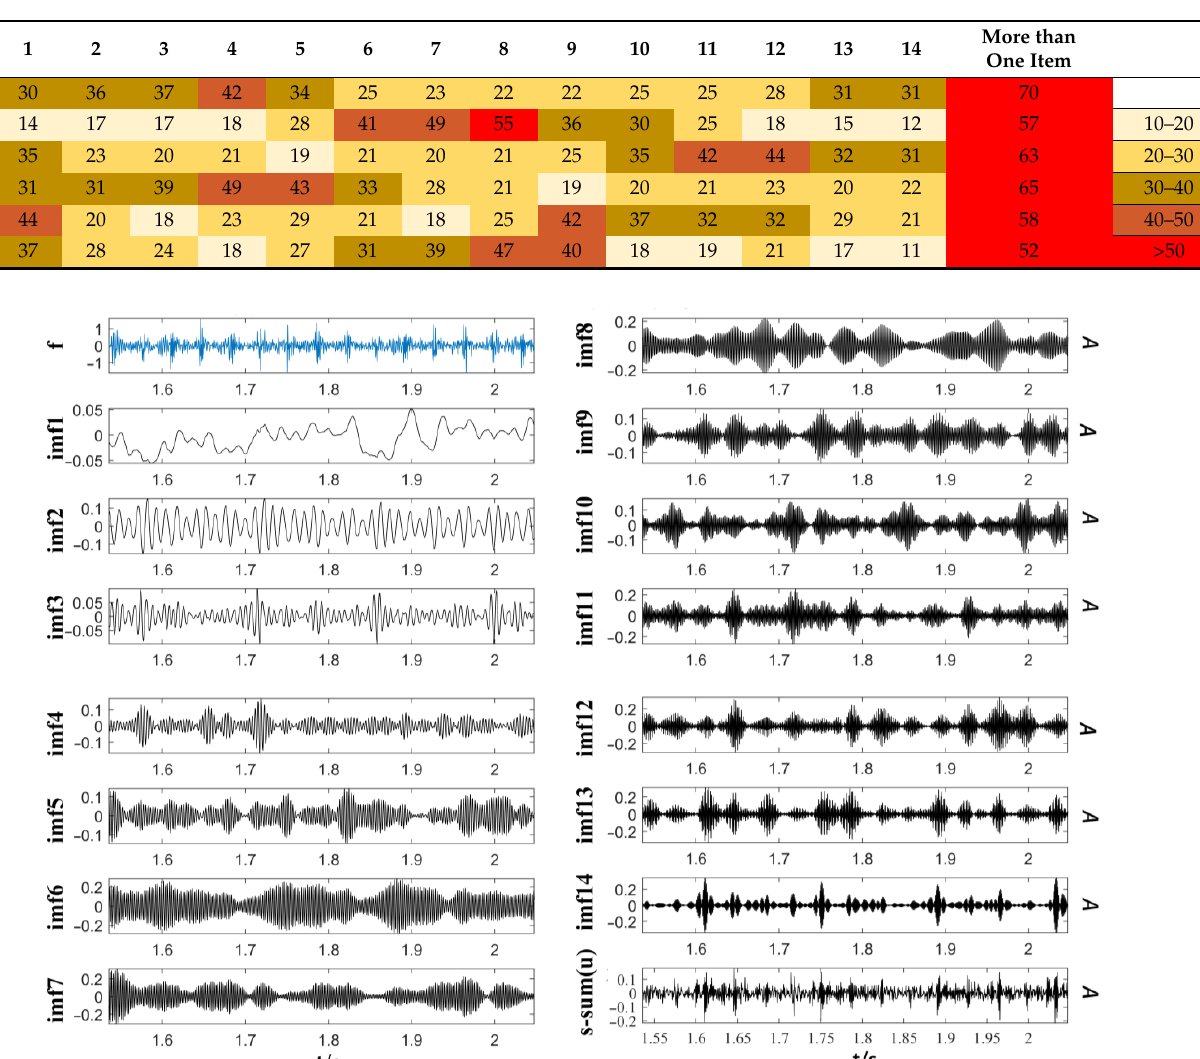
Table 4. Mean values of correlation coefficients of modes and original signal for 10 sets of data randomly selected for each working condition (%).